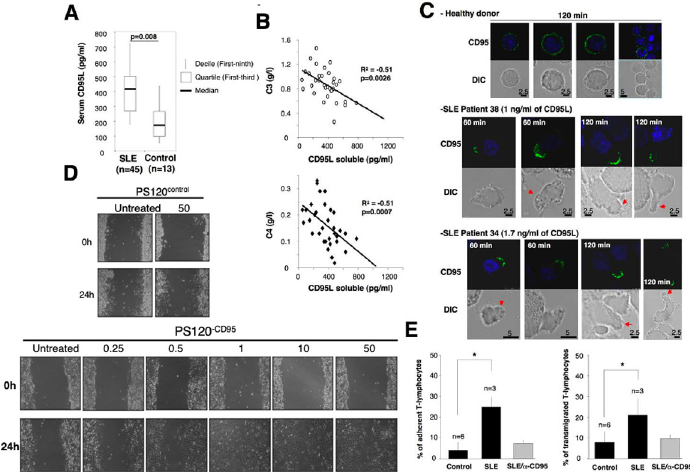
Fig 6. CD95L found in SLE patients promotes endothelial transmigration of activated PBLs. (A) By ELISA, the amounts of soluble CD95L in sera of healthy donors (control) and SLE patients were quantified. n stands for the number of SLE patients and healthy subjects. (B) Correlation between aggravation markers of the disease and the amount of soluble CD95L. (C) Activated PBLs were incubated for the indicated times with sera of healthy donors or SLE patients and the distribution of CD95 was analyzed by confocal microscopy. (D) All PS120 cells have been reconstituted with wild type NHE1 (see Materials and Methods). PS120 control cells do not express CD95, while its counterpart PS120 CD95 expresses a full length human CD95 (see Materials and Methods). A 24 h wound healing assay was performed. The fibroblastic cell line PS120 control or its CD95-expressing counterpart PS120 CD95 was grown to confluence. then the monolayer was “wounded” by scratching cells using a pipette tip. Using microscopy, the migration was monitored for 24 h with the indicated concentrations of cl-CD95L (ng/mL) as indicated in Materials and Methods. The untreated condition corresponds to cells incubated with a control medium (supernatant of pcDNA3.1(+)-transfected HEK cells). Pictures are representative of 3 independently performed experiments. (E) Activated PBLs were incubated in the presence of sera from SLE patients ( n = 3) or healthy donors ( n = 6), and then, adhesion to endothelial cells ( left panel ) and endothelial transmigration ( right panel ) of PBLs were assessed as described in Materials and Methods. Where indicated, activated PBLs were preincubated 30 min with the antagonist anti-CD95 mAb ZB4 ( α -CD95). ZB4 was maintained in the culture at 10 μ